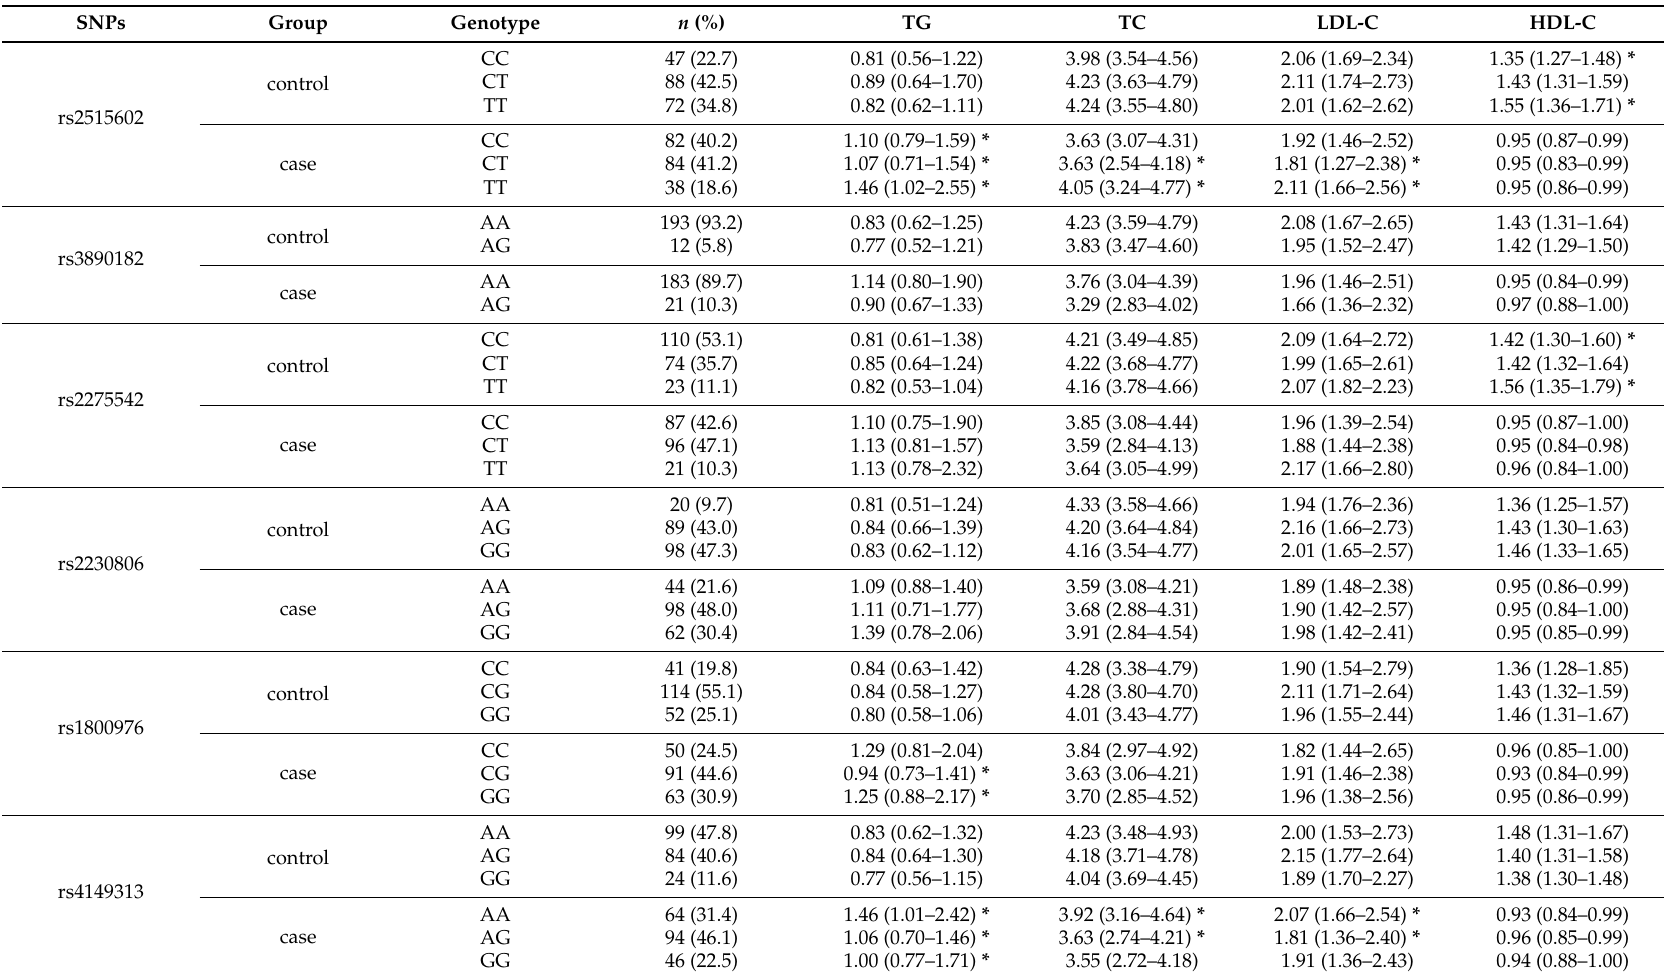
Table 4. The genotypes of six SNPs and serum lipid levels (mmol/L) between the subjects with normal HDL-C and low